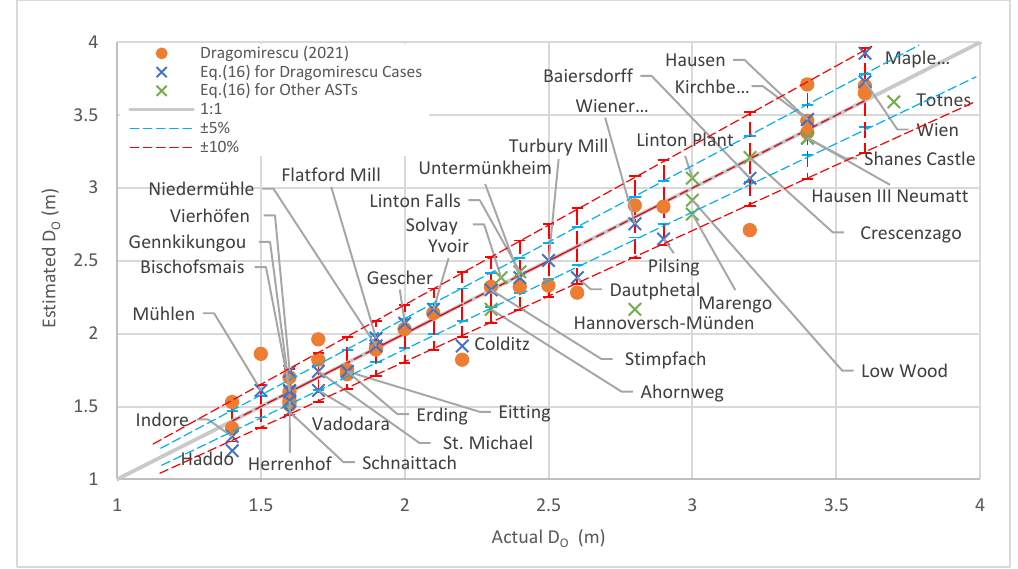
Figure 5. Comparison of Equation (16) results with Dragomirescu [17] and the other Archimedes screw installations (Table 2).